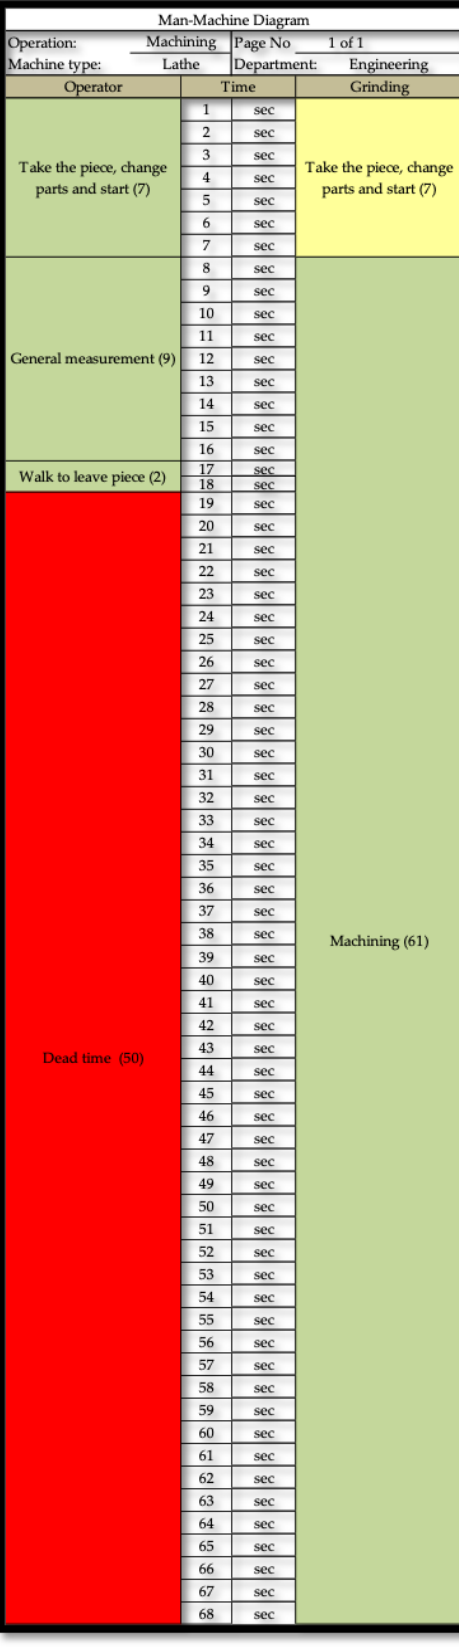
Table 1. Man-machine diagram of the lathe